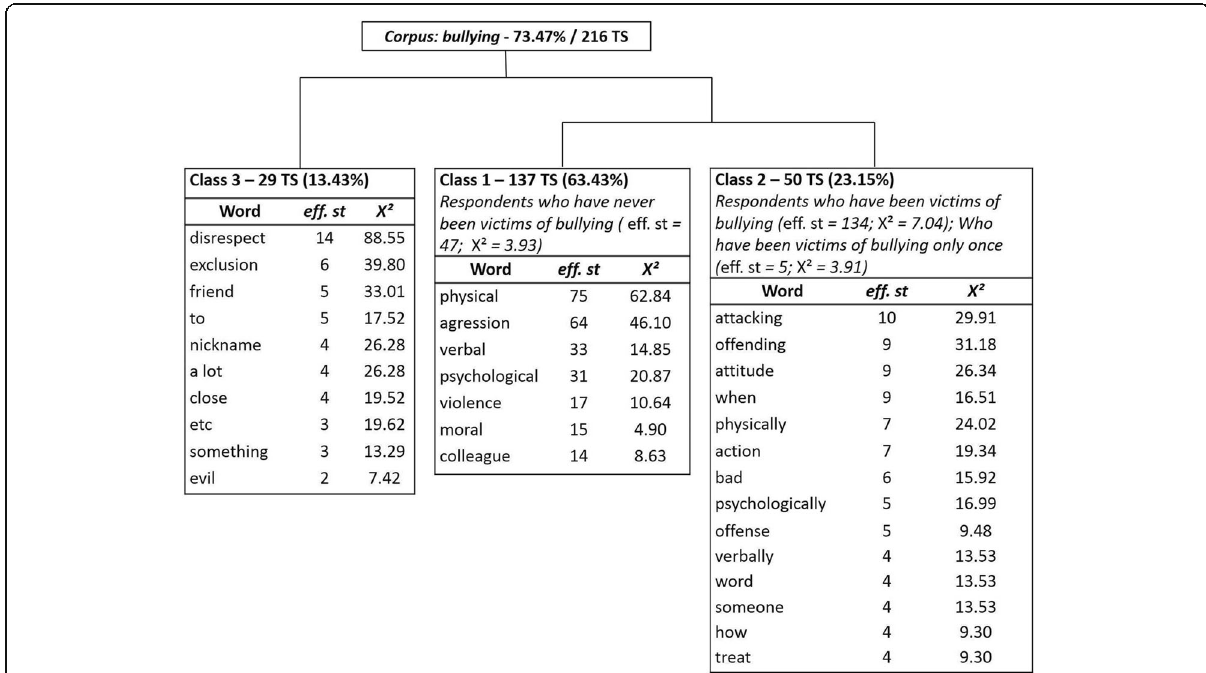
Fig. 1 Tree diagram of Descending Hierarchical Classification of the corpus <<What do you consider as bullying>>. Legend: Note. TS text segments, eff. st word frequency by text segments